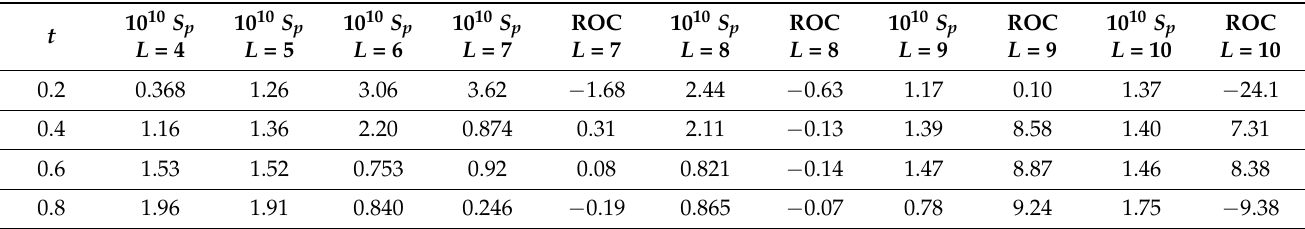
Table 8. The values of 10 10 S p and rate of convergence (ROC) at different points for k = 0 and various values of L by sine–cosine wavelets.